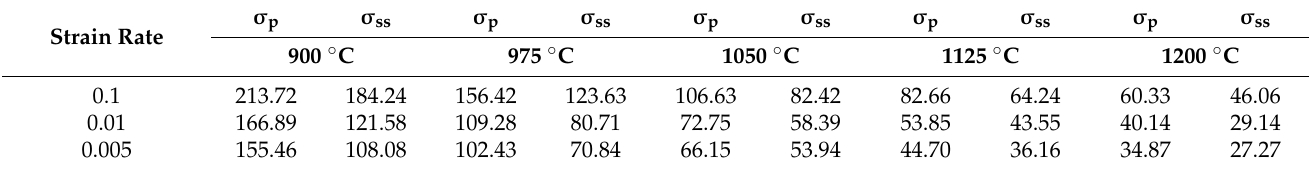
Table 2. The values of steady state stress and peak stress of Cr8 alloy steel at 900–1200 ◦ C